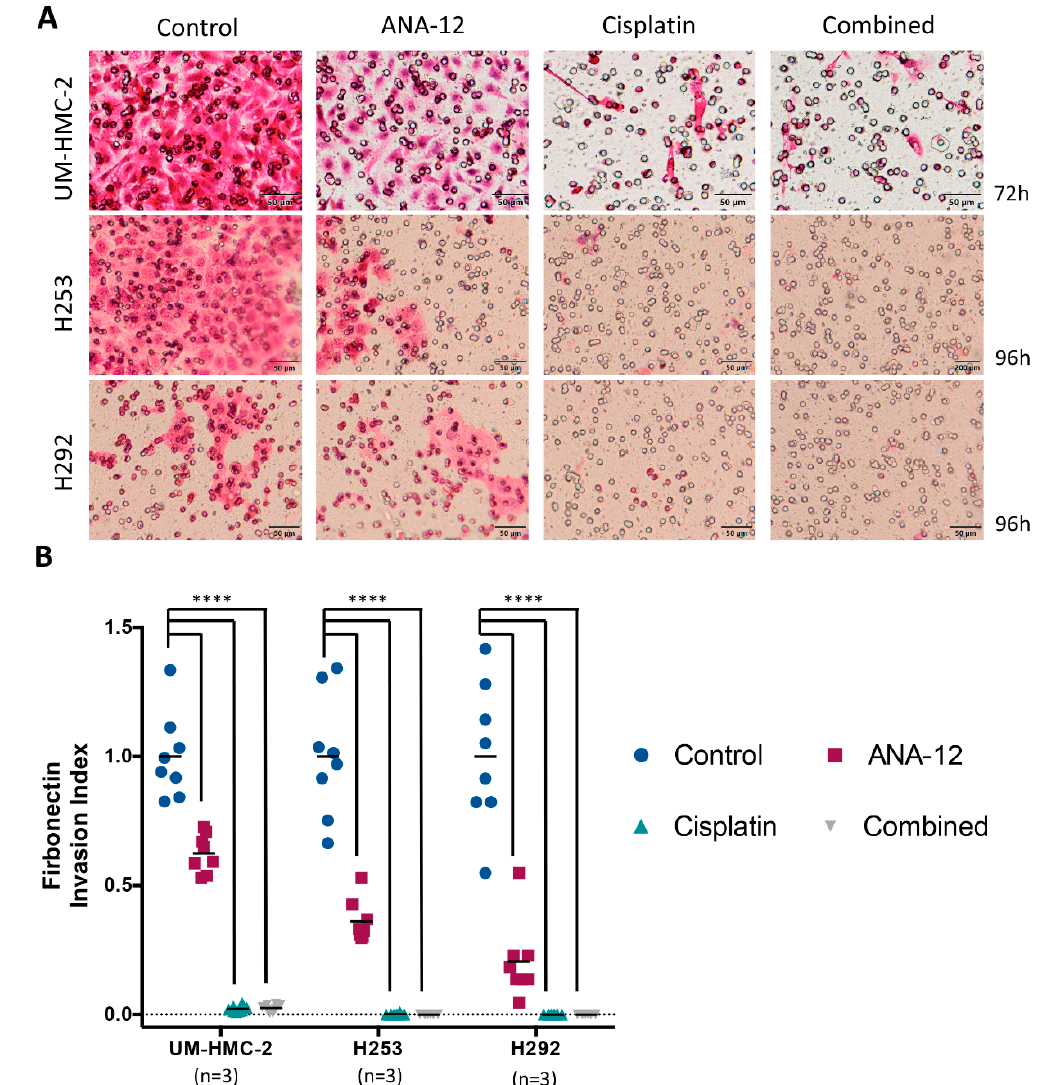
Figure 4. ( A ) Representative images of the invading cells following ANA-12, Cisplatin and combined treatment. Time of invasion is presented on the right side. ( B ) Quantitative analysis revealed that all treatments were effective in disrupting cell invasive capacities. Yet, note that Cisplatin and combined treatment achieved the most promising results for all cell lines (**** p < 0.0001).